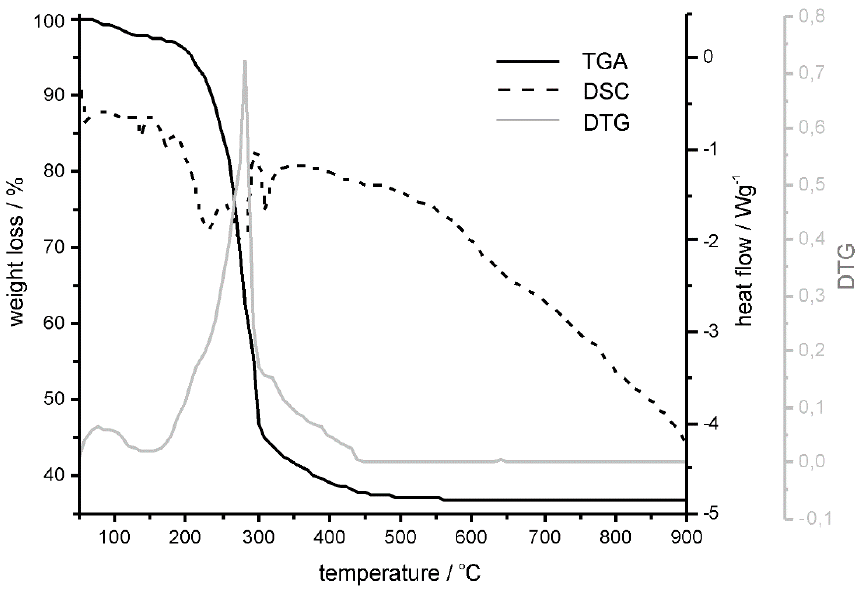
Figure 1. Differential scanning calorimetric (DSC), thermogravimetric (TGA) and derivative thermogravimetric (DTG) curves of the as-synthesized NiAl 2 O 4 before annealing.